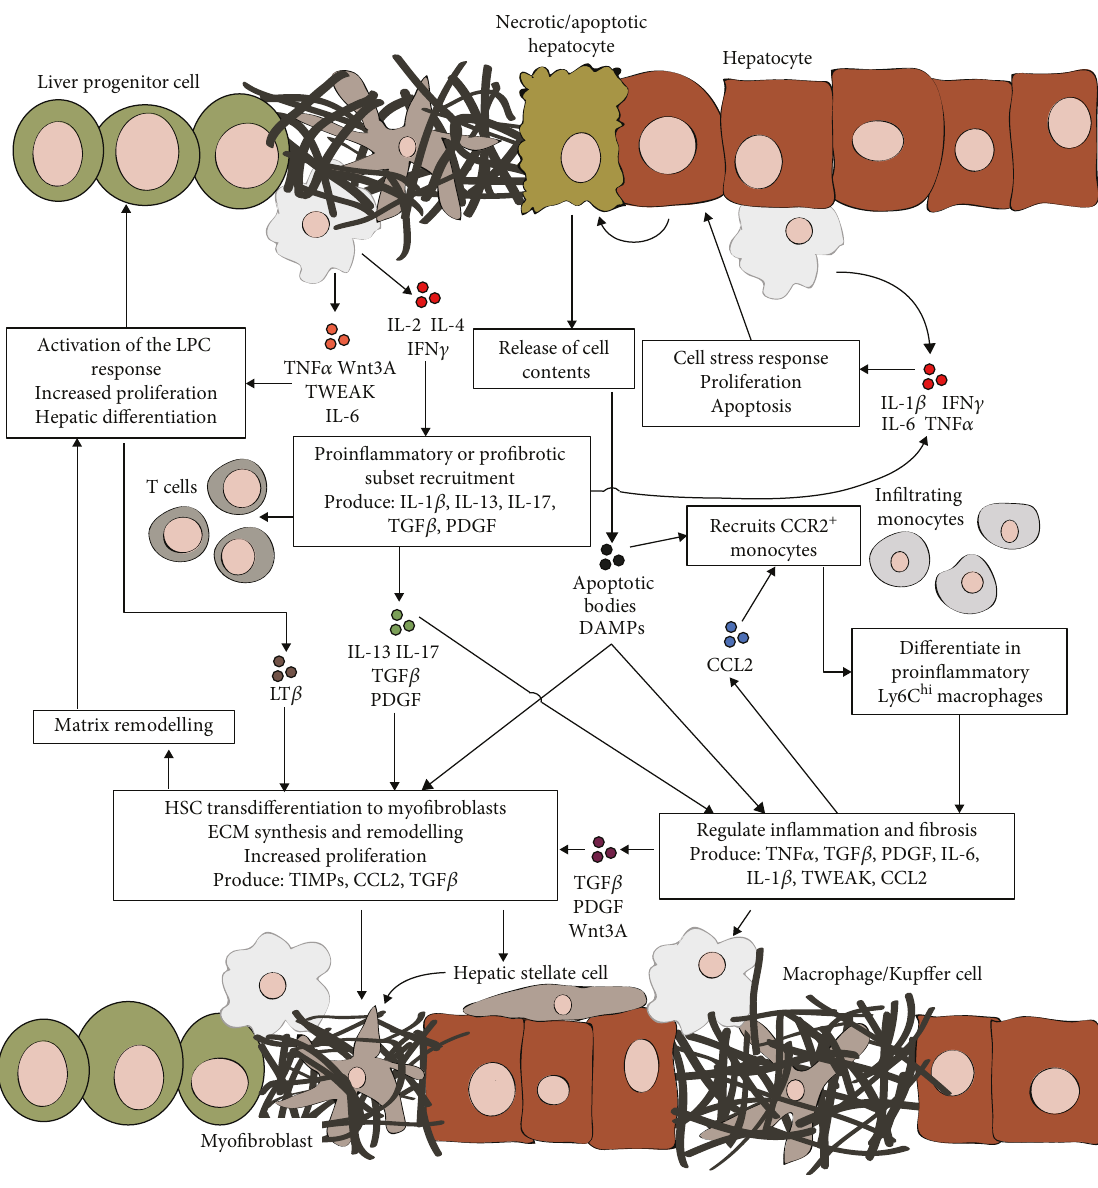
Figure 1: Overview of chronic hepatic wound healing and fi brosis. Necrotic and/or apoptotic hepatocytes release their cell content stimulating monocyte in fi ltration and hepatic stellate cell activation. Upon in fi ltration, monocytes di ff erentiate into proin fl ammatory Ly6C hi macrophages which, along with resident Kup ff er cells, release a myriad of proin fl ammatory and pro fi brotic cytokines. These factors promote additional in fl ammatory cell recruitment, regulate tissue repair, and activate hepatic stellate cells. Activated stellate cells transdi ff erentiate into ECM-producing myo fi broblasts. Myo fi broblasts also augment ECM remodelling by producing TIMPs and regulate tissue repair by secreting in fl ammatory and pro fi brotic factors. As a consequence of liver in fl ammation, T cells are recruited which further promote in fl ammation and/or stellate cell activation through cytokine production. Finally, persistent hepatic in fl ammation, ECM remodelling, and hepatocyte injury activate the liver progenitor cell compartment. Liver progenitor cells proliferate and di ff erentiate into hepatocytes to assist liver regeneration during CLD. CLD perpetuates this wound healing response resulting in persistent liver in fl ammation and the development of fi